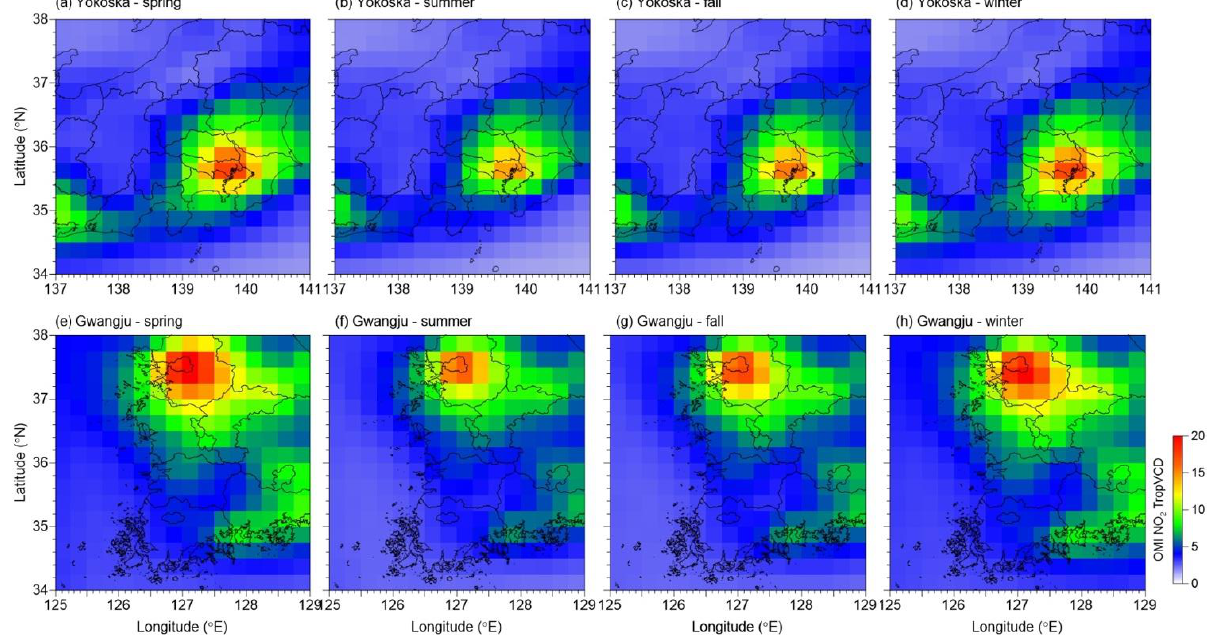
Figure 6. Seasonal distributions of NO 2 TropVCD (×10 15 molecules cm – 2 ) at Yokosuka, Japan ( a – d ) and Gwangju, Korea ( e – h ) measured from Ozone Monitoring Instrument (OMI; OMNO2d) from 2007 – 2017.